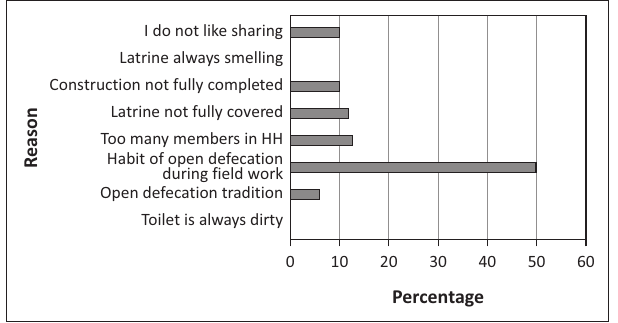
FIGURE 8: Reason for continued open